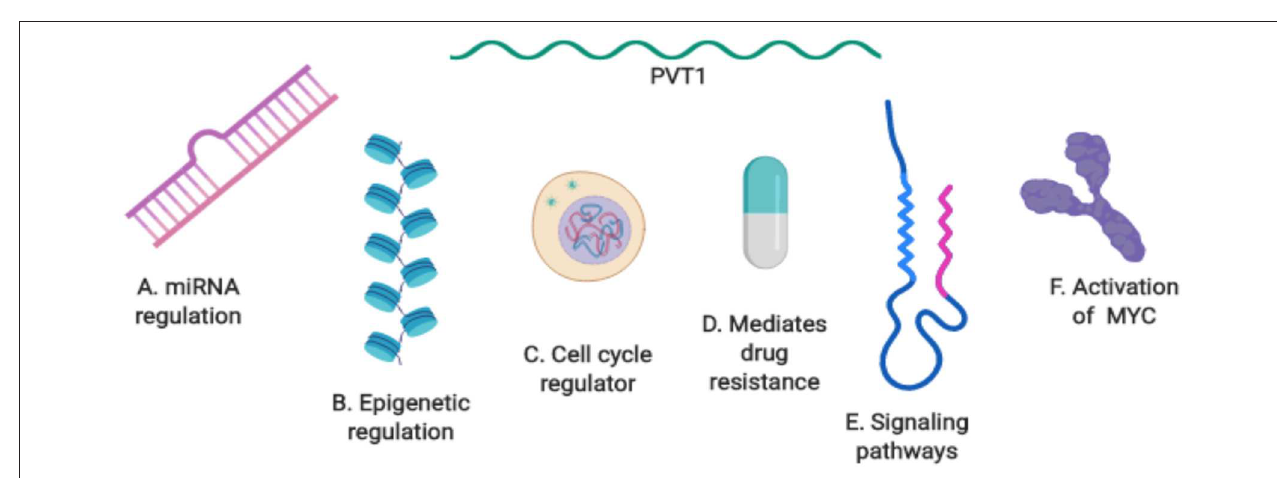
FIGURE 4 | Summary of PVT1 mechanisms of action in cancer. (A) PVT1 regulation by miRNA. (B) Epigenetic regulation by PVT1. (C) PVT1: a regulator of the cell cycle. (D) PVT1 mediates drug resistance. (E) PVT1 at the center of biological axes and signaling pathways. (F) The activation of PVT1 and MYC in cancer.